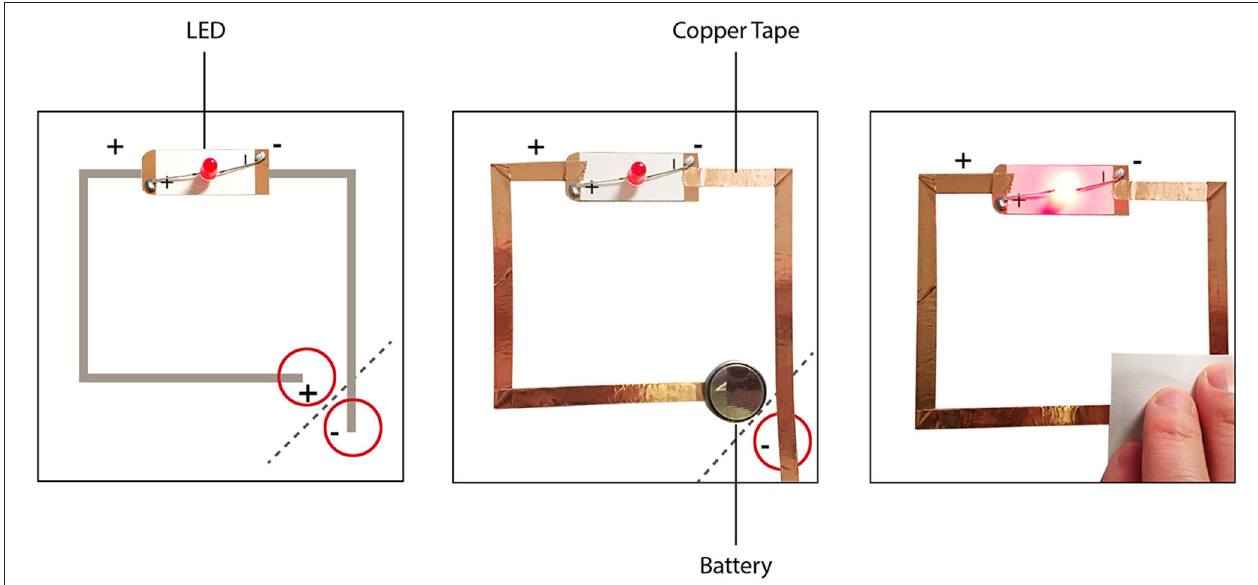
FIGURE 1 | Paper circuit